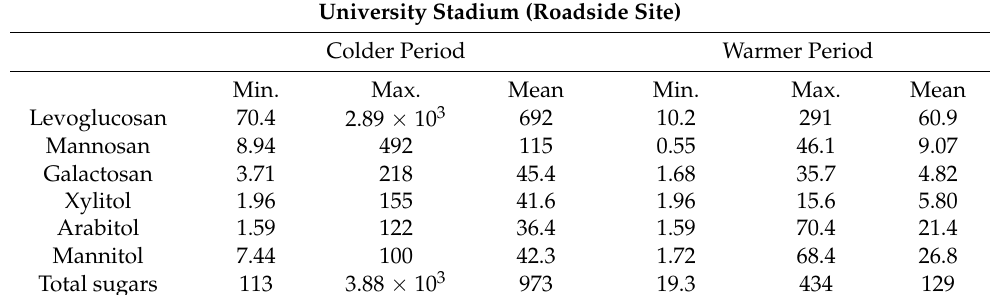
Table 4. Seasonal mean concentrations (ng · m − 3 ) of the selected sugars in PM 10 samples for each sampling site. University Stadium (Roadside Site) Colder Period Warmer Period Min.